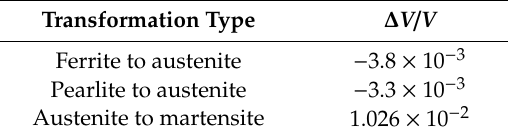
Table 5. Volume change ratio in phase transformation.